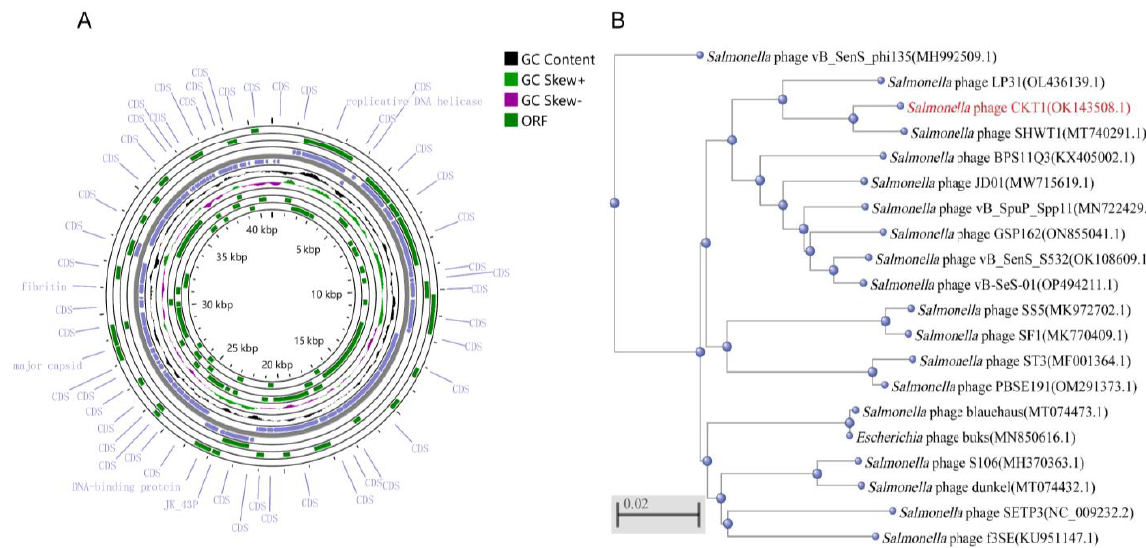
Figure 3. Genome analysis of phage CKT1. ( A ) Genome map of phage CKT1. ( B ) Phylogenetic tree based on the genome sequence of phage CKT1 by the neighbor-joining method .